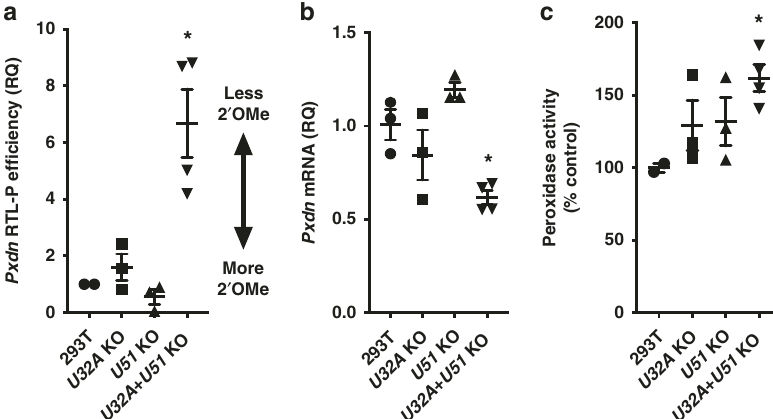
Fig. 2 Pxdn mRNA modi fi cation by Nm requires box C/D snoRNAs. 293T cell lines with CRISPR/ Cas9 knockout (KO) for U32A ( n = 3), U51 ( n = 3), or U32A + U51 ( n = 4). Each KO cell line is an independent biological sample, analyzed in two independent experiments. Mean and SEM error bars, * p < 0.05 vs. 293T, by one-way ANOVA. a Pxdn mRNA from snoRNA KO cells showed loss of Nm (* p = 0.0086). b snoRNA KO cells showed reduced Pxdn mRNA (* p = 0.0128). c Peroxidase activity in cells was measured using Amplex Red and normalized to WT (* p =